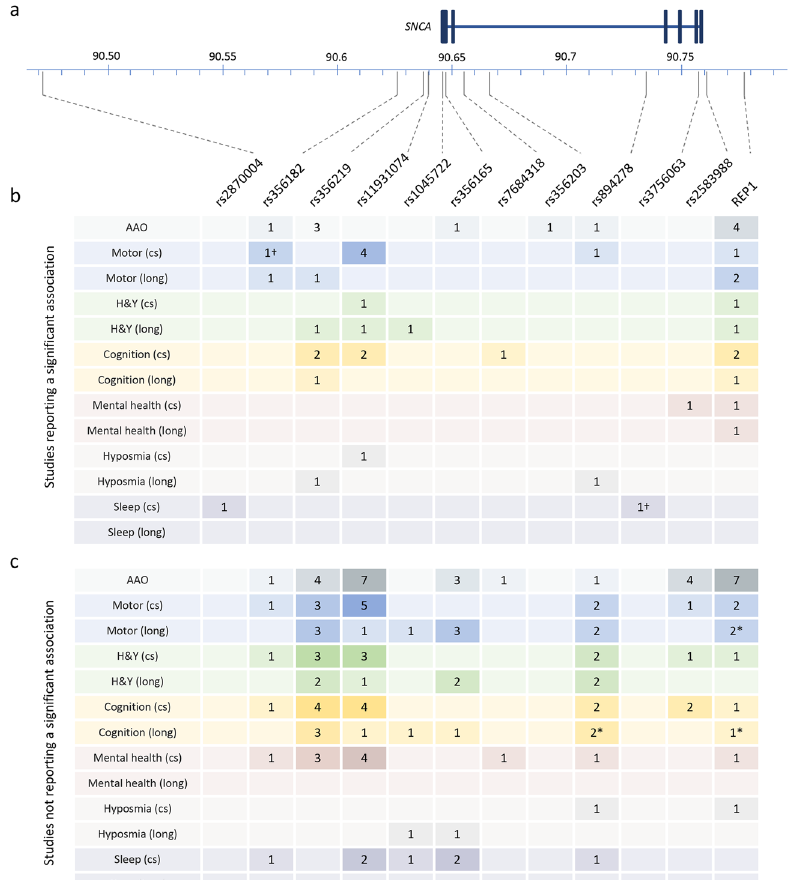
Fig. 2 Summary of SNCA polymorphisms identi fi ed in this review that were reported to be associated with a clinical outcome in Parkinson ’ s disease. a Schematic of SNCA showing the location of each polymorphism. Exons are indicated by boxes. Chromosome 4 positions according to GRCh 37. Adapted from the output generated by LDLink 83 . b The number of studies reporting a signi fi cant association of a clinical outcome with the polymorphism indicated. c The number of studies reporting no signi fi cant association between a clinical outcome with the polymorphism indicated. In both b and c , the analysis of clinical outcomes is separated according to a cross-sectional (cs) or longitudinal (long) study design. A single study can be recorded more than once if both designs were included in the manuscript or if the study reported both signi fi cant and non-signi fi cant associations for a SNP in the same category. Full details of the SNPs and the outcomes in each category are given in Supplementary Tables 2 and 3. Asterisk (*): the unadjusted p value was <0.05 but the authors reported that the association did not remain signi fi cant after adjustment for multiple testing or covariates. Dagger ( † ): the study identi fi ed the association in a discovery cohort and replicated the fi nding in an independent cohort. AAO age at onset, cs cross-sectional, H&Y Hoehn and Yahr, long